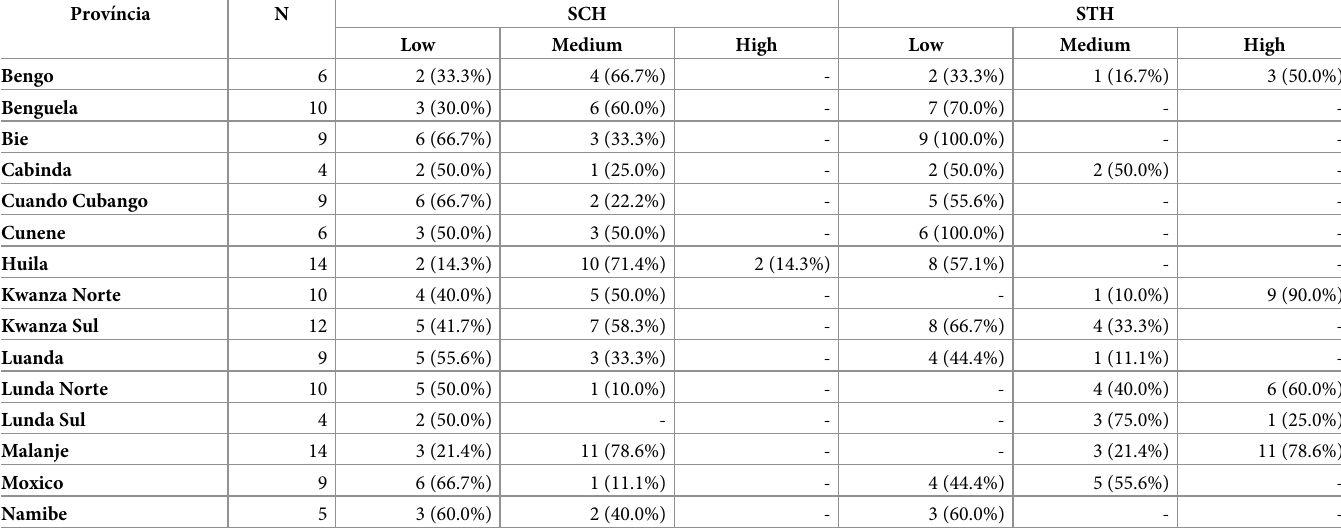
Table 3. Number of districts in each province to be targeted for MDA according to mapped